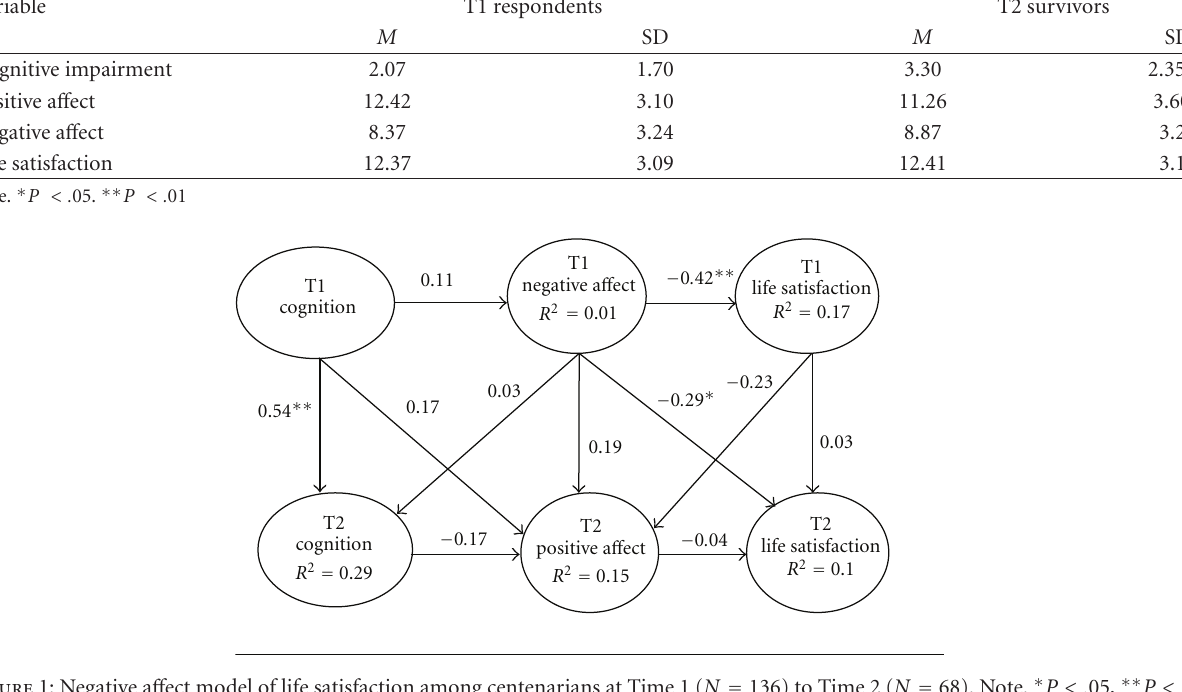
explained by cognition and positive a ff ect at Time 1.